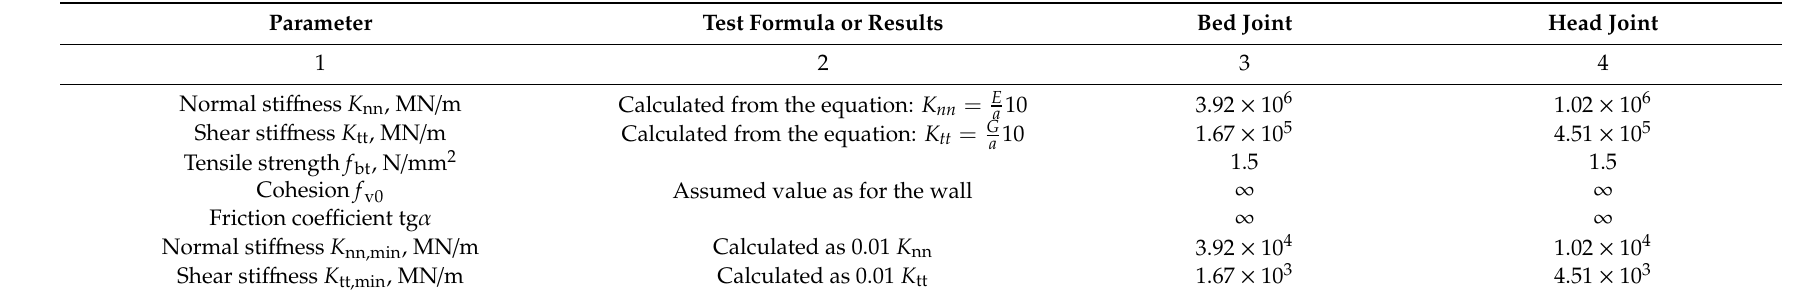
Table 6. Parameters of interface elements at the interface of the wall and reinforced concrete